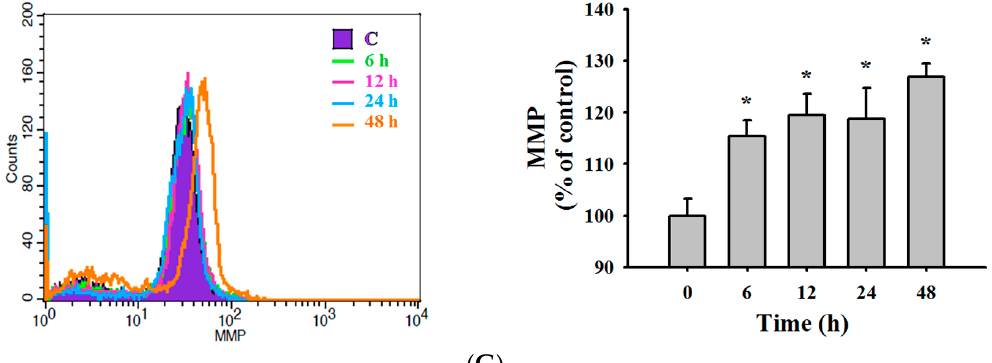
Figure 4. TET induces reactive oxygen species (ROS) and Ca 2+ production and affects the levels of mitochondrial membrane potential ( ΔΨ m ) in NPC-TW 076 cells. Cells (1 × 10 5 cells/well) were treated with TET (8 μ M) for various time periods. Cells were isolated and then were re-suspended in DCFH-DA for ROS (H 2 O 2 ) ( A ) and cells were pretreated with NAC and then were measured for ROS ( B ) and the number of viable cells ( C ), re-suspended in Fluo-3/AM for further intracellular Ca 2+ concentrations ( D ) and cells were pretreated with NAC ( E ) or 4PBA ( F ) and then were measured for Ca 2+ production, and re-suspended in DiOC 6 for the levels of Ψ m measurement ( G ) as described in Materials and Methods. The results are shown as a mean ± SD ( n = 3); * p < 0.05 or *** p < 0.001 significant difference between TET-treated groups and the control as analyzed by Student’s t test.